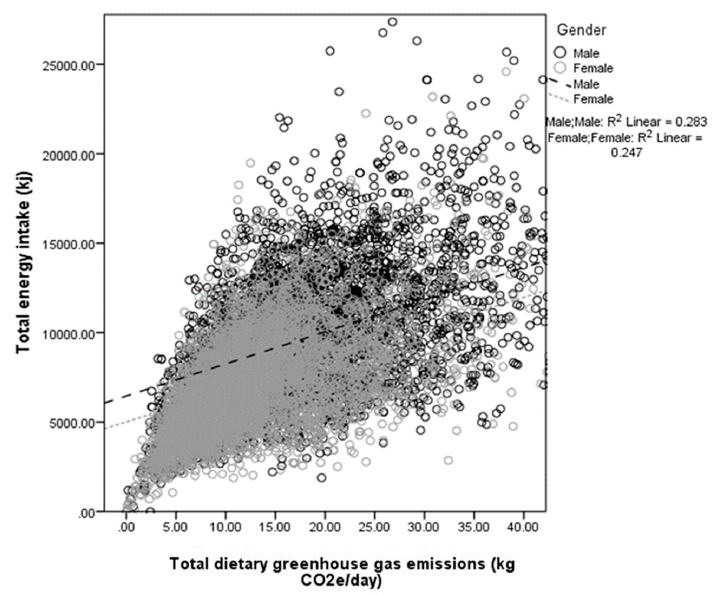
Figure 1. Distribution of total dietary greenhouse gas emissions for Australian males (black dashed line, n = 4282) and Australian females (grey dotted line, n = 5059).